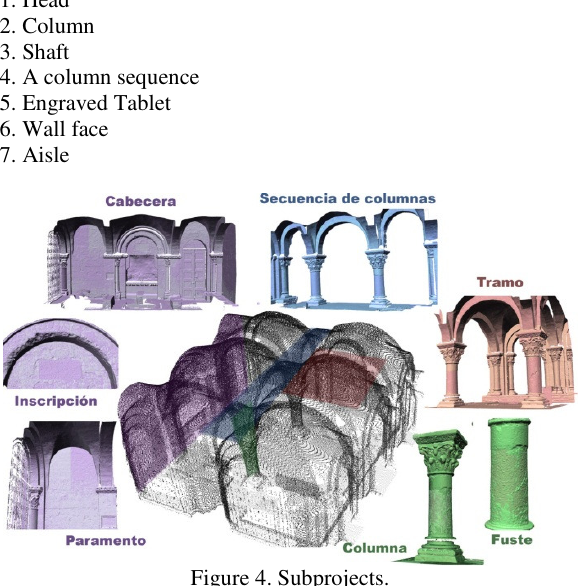
Figure 4. Subprojects.